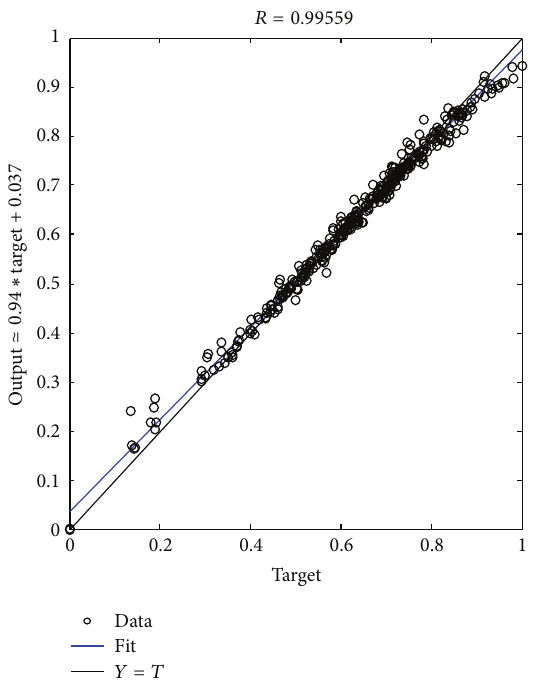
Figure 16: Comparison between measured and predicted data. fit as shown in Table 3. The monthly measured testing data are presented in Figures 12, 13, and 14 based on a spread of 0.04. Comparing the results of FFBP and GRNN shows that FFBP is more accurate compared with